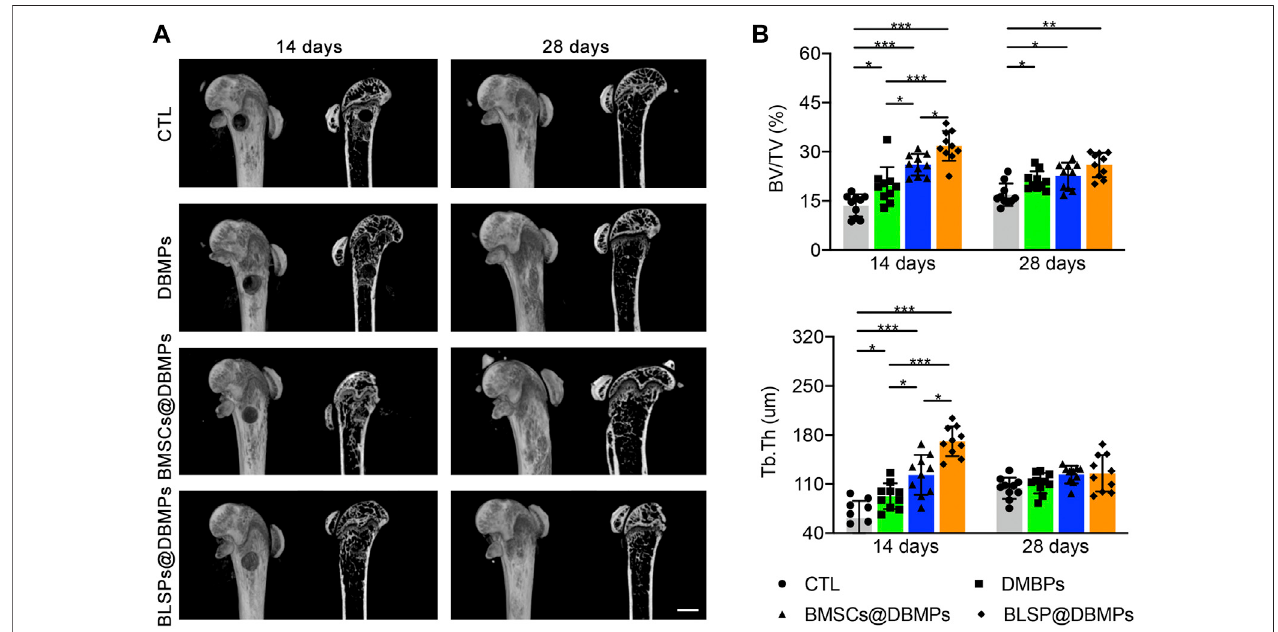
FIGURE 6 | (A) Representative micro-CT images of the defected femur in the CTL, DBMP, BMSCs@DBMP, and BLSP@DBMP groups at postoperative 14 and 28 days. Bar = 1 mm. (B) Comparison ofthe BV/TV and Tb.Th in the newly formed bone among the four groups at different time points. n = 10for each group. Data are showed as means ± standard deviation (* p < 0.05, ** p < 0.01, and *** p < 0.001).